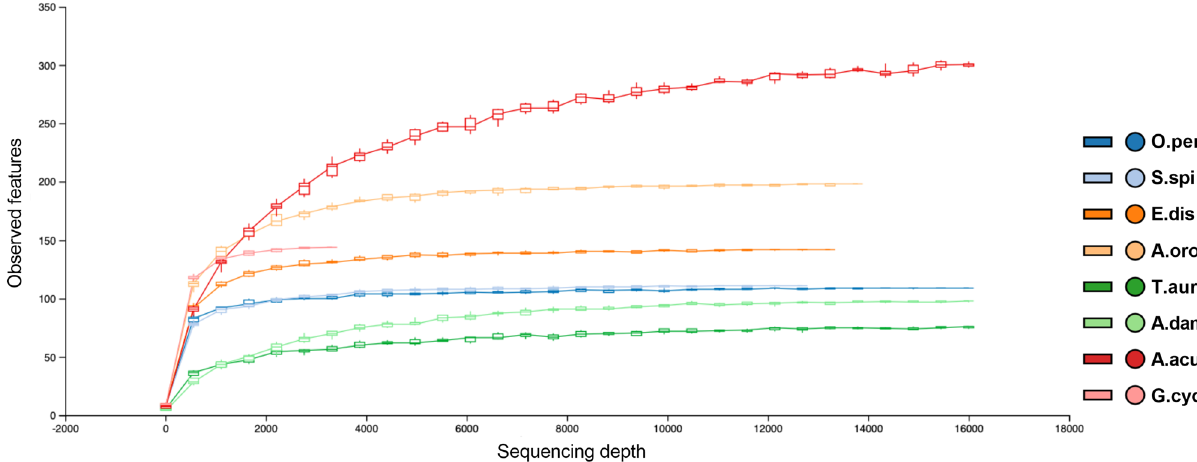
Figure 1. Alpha rarefaction of the observed features for each sponge sample under analysis. Sample IDs: O.per = Oceanapia cf. perforata , S.spi = Sarcotragus spinosulus , E.dis = Erylus discophorus , A.oro = Agelas oroides , T.aur = Tethya aurantium , A.dam = Axinella damicornis and A.acu = Acanthella acuta